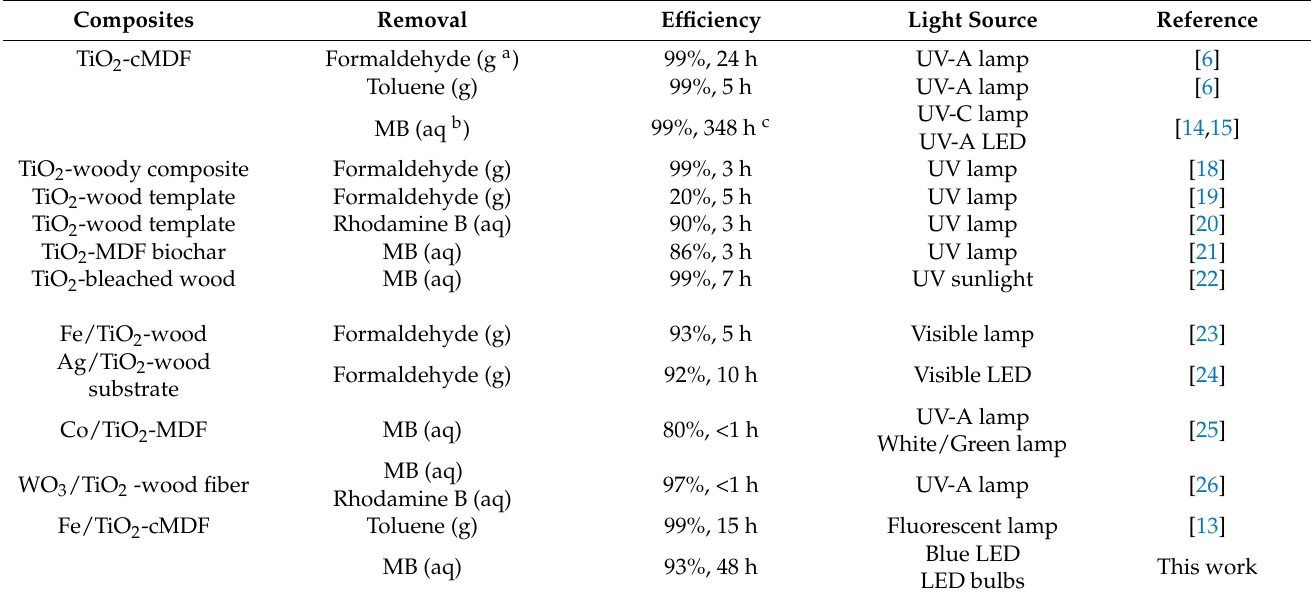
Table 7. TiO 2 -based wood and wood-based